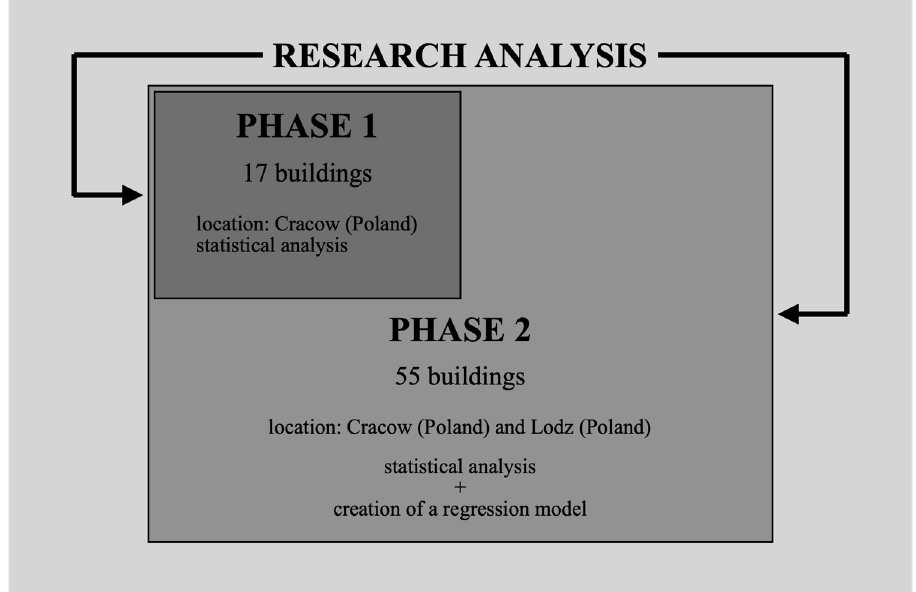
Figure 1. Research analysis, the two phases of the research.